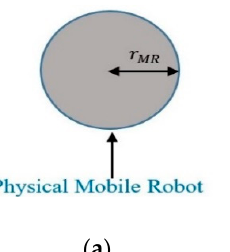
Figure 5. Solution construction in ant colony optimization (ACO) algorithm.